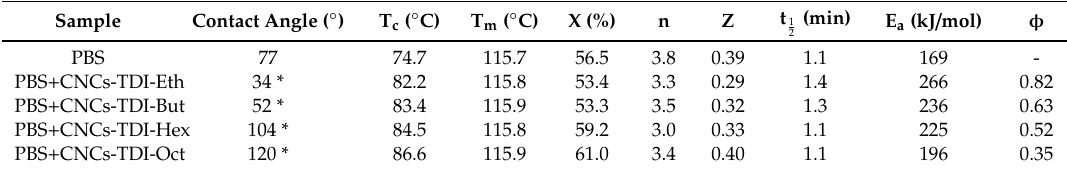
Table 4. Summary of the impact of CNC surface properties on the crystallization of PBS (at 10 ◦ C / min).